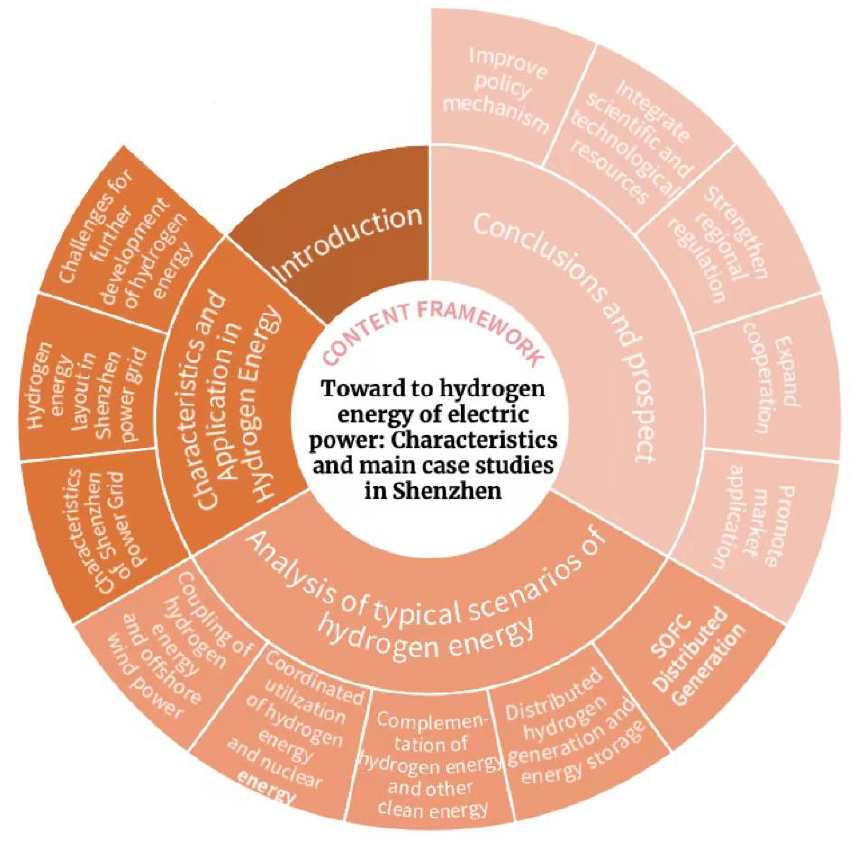
Figure 1. Content framework of this paper.